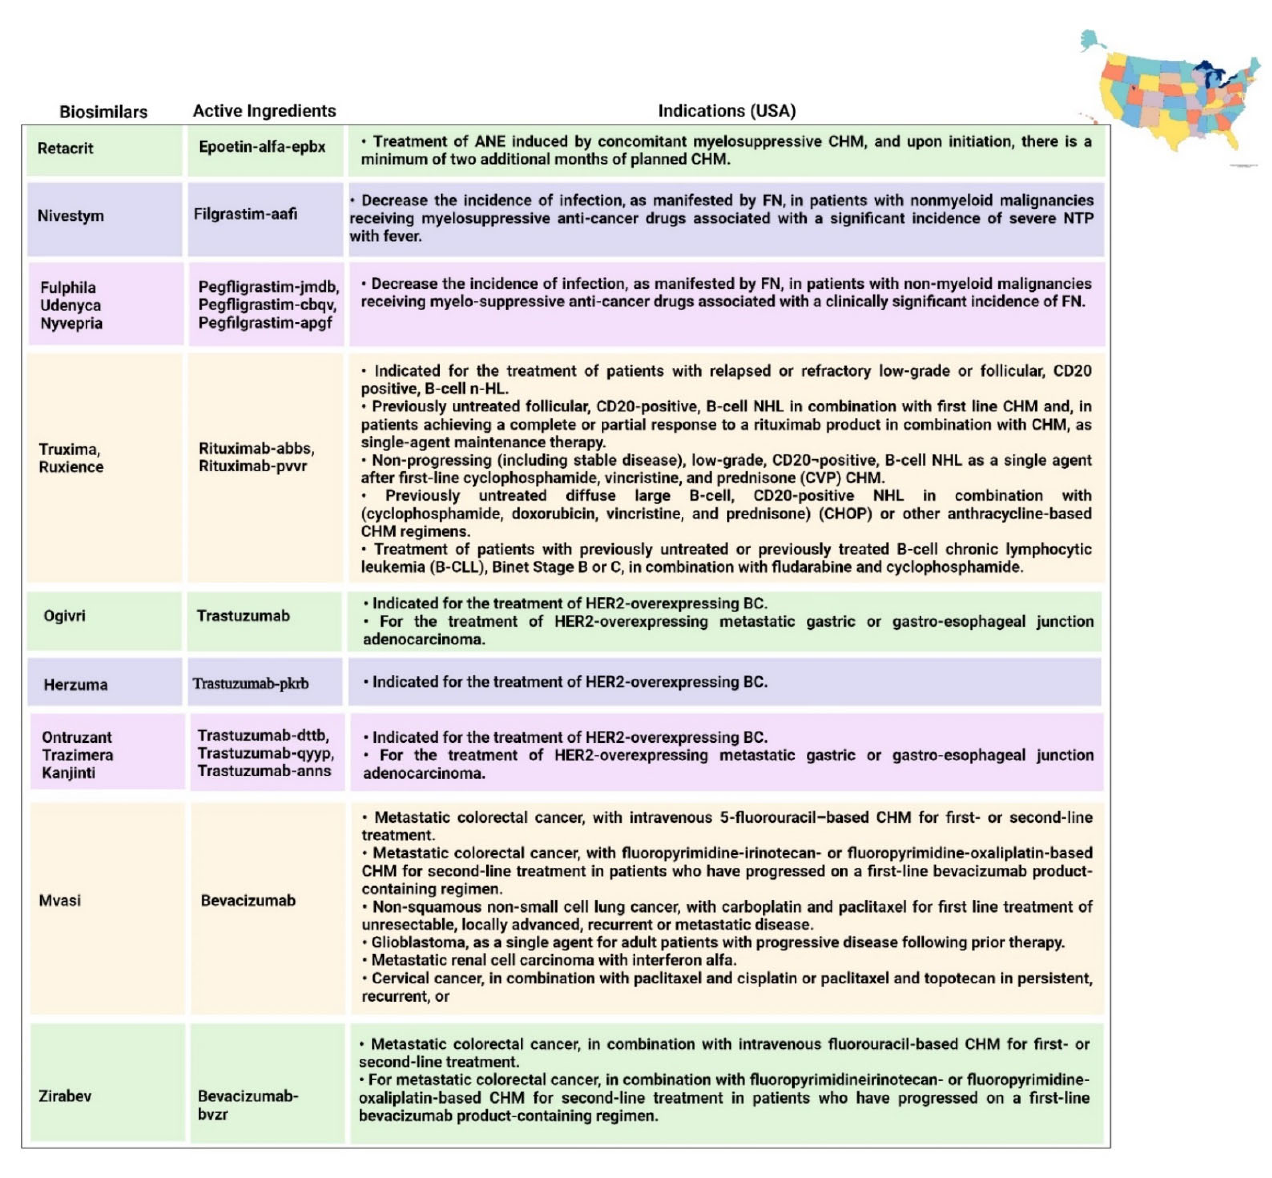
Figure 6. Indications approved in the USA for biosimilars [40,42,52,58–60,66,67,69,73–77,79,119–125]. ANE = anemia; B-CLL = B-cell lymphocytic leukemia; CHM = chemotherapy; NTP = neutropenia; FN = febrile neutropenia; ML = myeloid leukemia; PBPC = peripheral blood progenitor cell; HER2 = human epidermal growth factor receptor 2; MBC = metastatic breast cancer; EBC = early breast cancer; n-HL = non-Hodgkin lymphoma; CLL = chronic lymphocytic leukemia; GPA = granulomatosis with polyangiitis; MPA = microscopic polyangiitis; CHOP = cyclophosphamide, doxorubicin hydrochloride (hydroxydaunorubicin), vincristine sulfate (Oncovin), and prednisone.